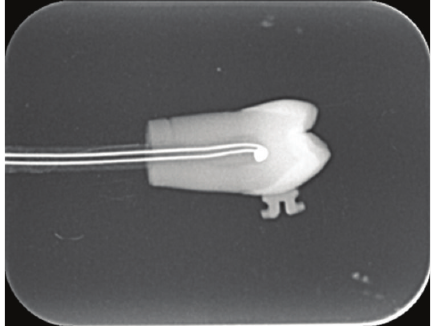
Figure 1: Radiographic image of the thermocouple positioned inside the pulp.